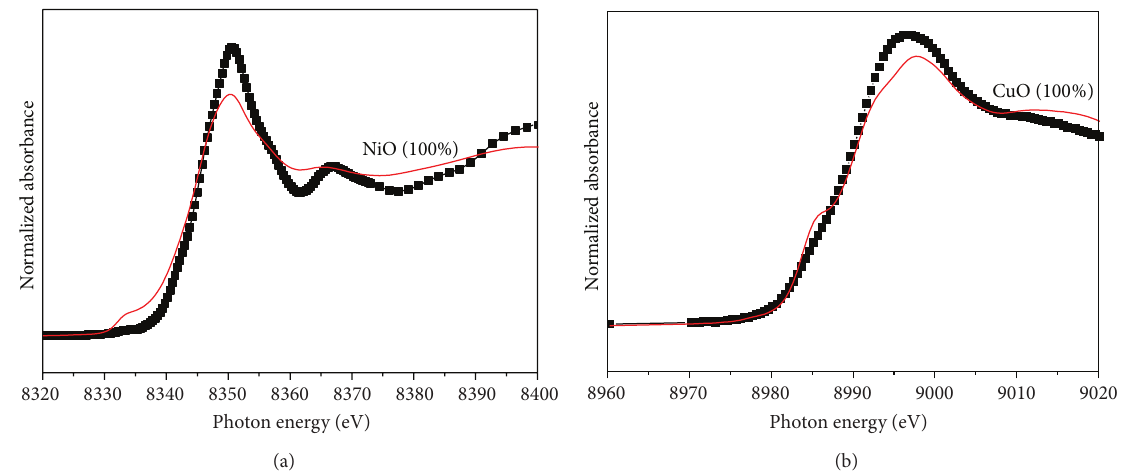
Figure 2: Component-fitted XANES spectra of (a) nickel and (b) copper in the NiO/nano-TiO 2 and CuO/nano-TiO 2 photocatalysts, respectively.